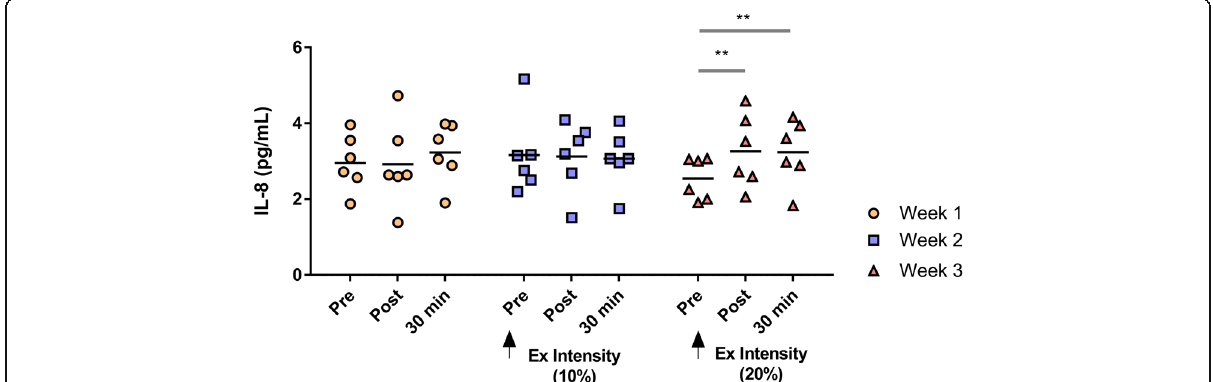
Fig. 8 Plasma [IL-8] during 3 weeks of exercise training ( N = 6). A significant main effect of interaction (time x intensity) was observed ( P = 0.04). Post hoc Tukey ’ s multiple testing showed significant differences in week 3, between Pre and Post ( P < 0.01), and between Pre and 30 min ( P < 0.01). ** P < 0.01